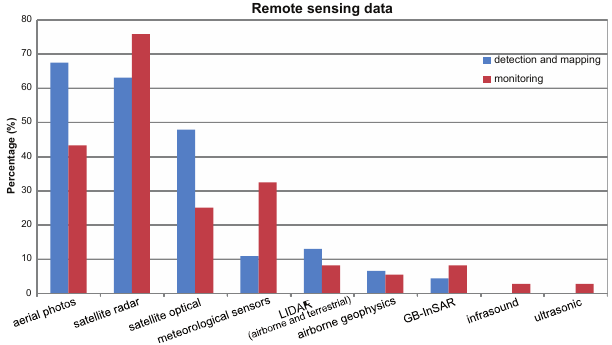
Fig. 2. Remotely sensed data in landslide